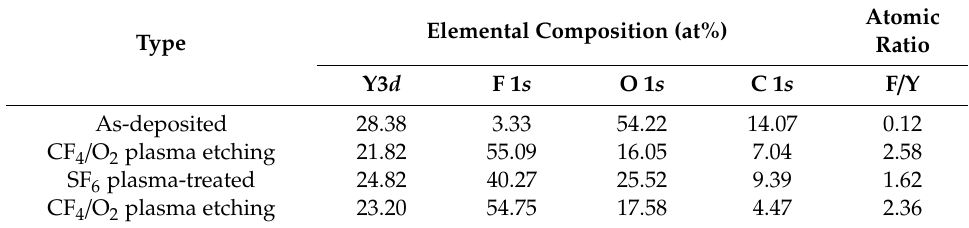
Table1. X-rayphotoelectronspectroscopy(XPS)resultsoftheas-depositedY 2 O 3 andSF 6 plasma-treated Y 2 O 3 film before and after exposure to CF 4 / O 2